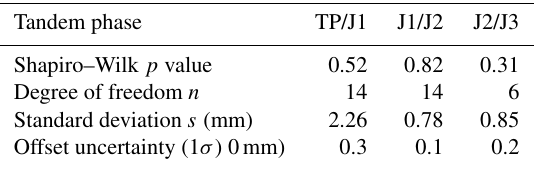
Table 3. L2P21 GMSL intermission offset uncertainties (1 σ ) as estimated in this paper. The results (bottom line) can be re-estimated with Eq. (1) and the different parameters given